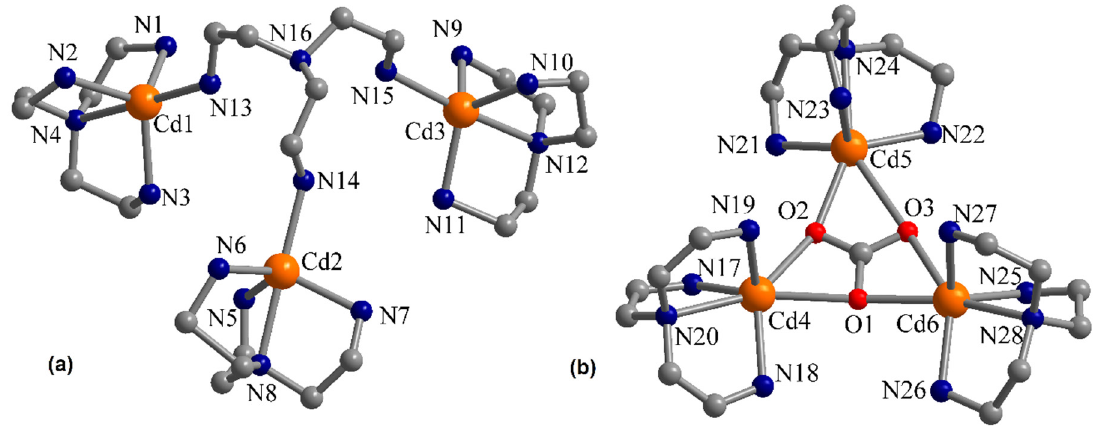
Figure 3. Perspective views of the two cationic complexes of the compound 2 , [{Cd(tren)} 3 (tren)] 6+ ( a ) and [{Cd(tren)} 3 ( µ 3 − CO 3 )] 4+ ( b ). The hydrogen atoms were omitted for clarity. The cation [{Cd(tren)} 3 (tren)] 6+ preserves its general features from the compound 1 (Figure 3a). The Cd(II) ions from this cation are also pentacoordinated with a trigonal bi- pyramidal stereochemistry. The equatorial Cd-N bond lengths are: Cd1-N1 = 2.296(19), Cd1-N2 = 2.283(14), Cd1-N3 = 2.258(14), Cd2-N5 = 2.43(2), Cd2-N6 = 2.24(2), Cd2-N7 = 2.21(2), Cd3-N9 = 2.289(16), Cd3-N10 = 2.215(12) and Cd3-N11 = 2.236(15) Å, while the axial Cd-N bond lengths are: Cd1-N4 = 2.402(11), Cd1-N13 = 2.265(13), Cd2-N8 = 2.354(13), Cd2-N14 = 2.305(17), Cd3-N12 = 2.397(13) and Cd3-N15 = 2.299(12) Å. The Cd···Cd dis- tances within the trinuclear complex are: Cd1···Cd2 = 6.68, Cd2···Cd3 = 7.04 and Cd3···Cd1 = 7.80 Å. In the second trinuclear cationic complex, [{Cd(tren)} 3 (µ 3 -CO 3 )] 4+ , the carbonate anion coordinates in the µ 3 -k 2 :k 2 :k 2 bridging tris-chelating fashion (Figure 3b). The coordination number for the three Cd(II) ions is six, the axial amino group of the bridging tren molecule being replaced by two chelating oxygen atoms of the carbonate anion. In the cation [{Cd(tren)} 3 (µ 3 -CO 3 )] 4+ the Cd-N bond lengths are: Cd4-N17 = 2.278(14), Cd4-N18 = 2.307(14), Cd4-N19 = 2.276(11), Cd4-N20 = 2.471(9), Cd5-N21 = 2.292(13), Cd5-N22 = 2.260(12), Cd5-N23 = 2.261(12), Cd5-N24 = 2.453(10); Cd6-N25 = 2.290(12), Cd6-N26 = 2.279(11), Cd6-N27 = 2.281(10) and Cd6-N28 = 2.434(10) Å, while the Cd-O bond lengths are: Cd4-O1 = 2.429(8), Cd4-O2 = 2.430(8), Cd5-O2 = 2.327(8), Cd5-O3 = 2.629(9), Cd6-O1 = 2.347(8) and Cd6-O3 = 2.556(9) Å. The Cd···Cd distances within the tetracationic trinuclear complex are shorter: Cd4···Cd5 = 4.66, Cd5···Cd6 = 5.11 and Cd6···Cd4 = 4.68 Å. The two types of trinuclear cations, [{Cd(tren)} 3 (tren)] 6+ and [{Cd(tren)} 3 (µ 3 -CO 3 )] 4+ , are also arranged in layers, but in the crystallographic bc plane (Figure 4). In these layers, each type of trinuclear cation forms columns running along the crystallographic b axis with an alternating distribution of the two types of columns within the layer. Similarly to compound 1, the arms of the tripodal cations [{Cd(tren)} 3 (tren)] 6+ are orientated on the same direction within one layer and in opposite directions in the neighboring layers.